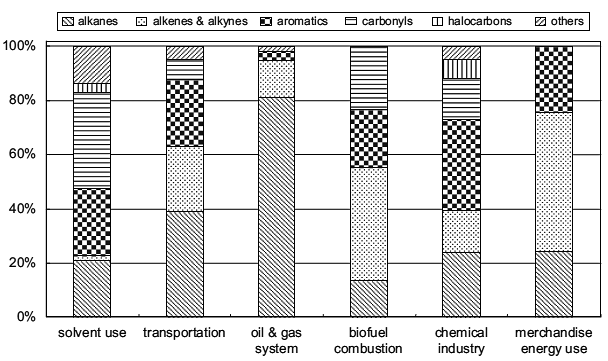
Figure 14. Chemical speciation for various emission sectors in China (Wei et al., 2008) showing the wide variation of VOCs with source that need to be represented in emission